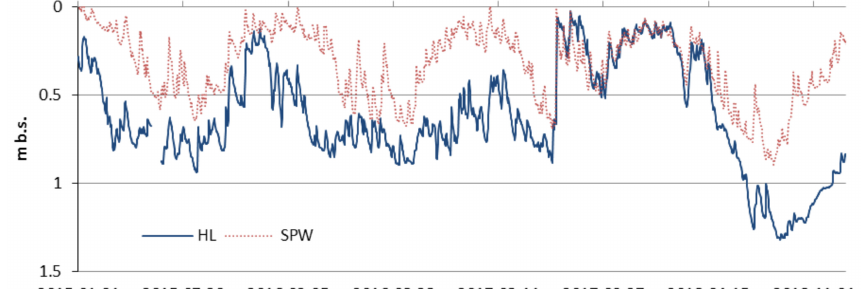
Figure 3. Daily average water table depths below surface in Havelländisches Luch (HL) and Spree- wald (SPW) from 2015 to